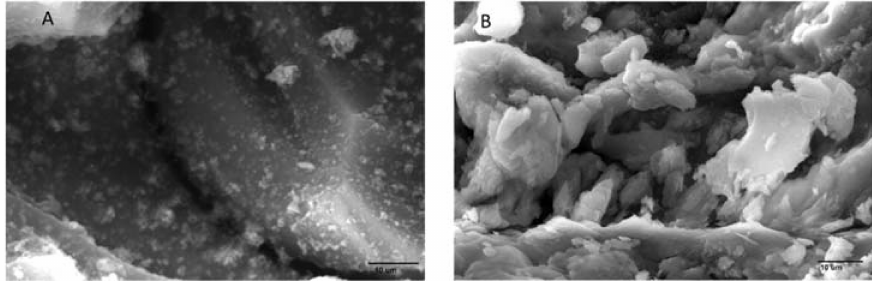
Figure 3. SEM images of aminated graphene oxide ( A ) and graphene oxide ( B